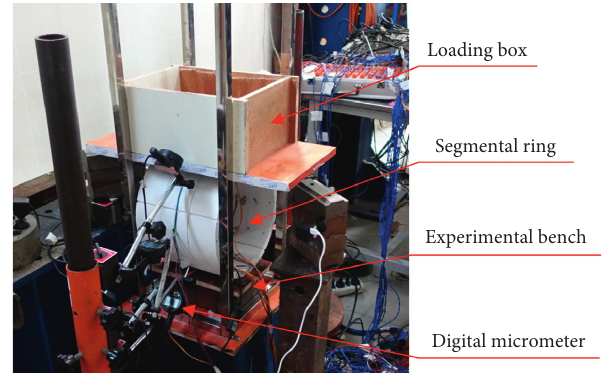
Figure 10: Apparatus of model loading test.